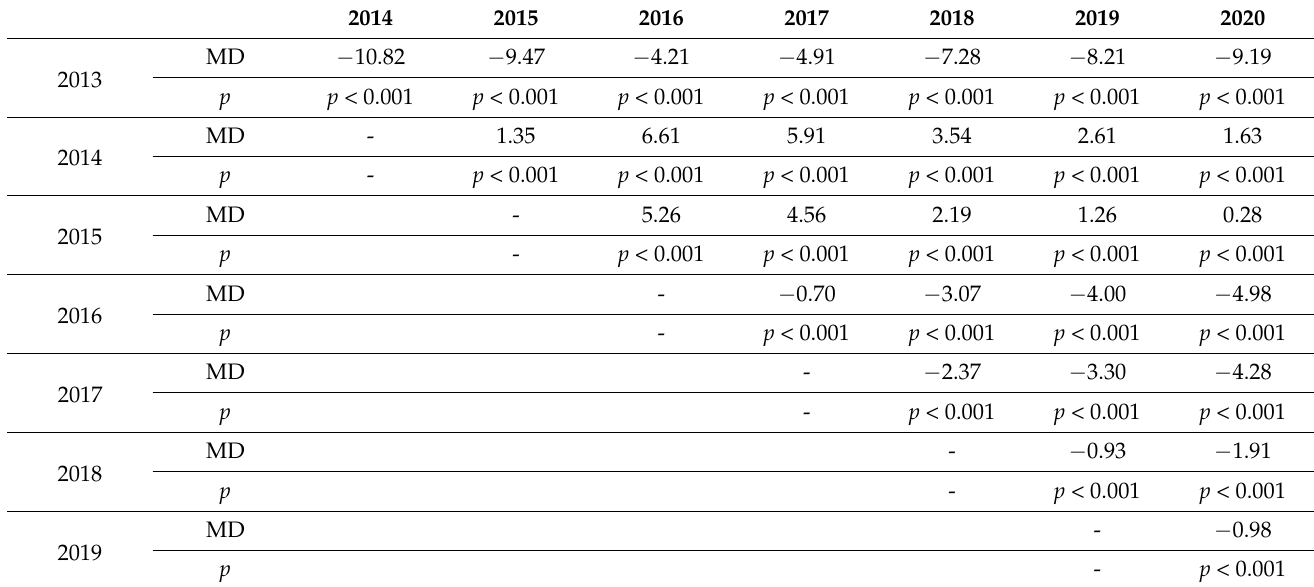
Table 4. Comparison of pulse checking in the case of VT and PEA by MRT members between individual editions of the Championships.